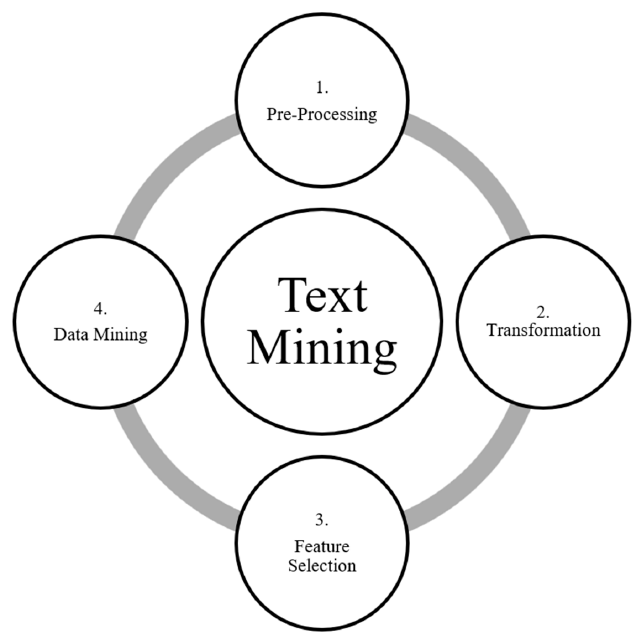
Figure 1. Process of Text Mining .